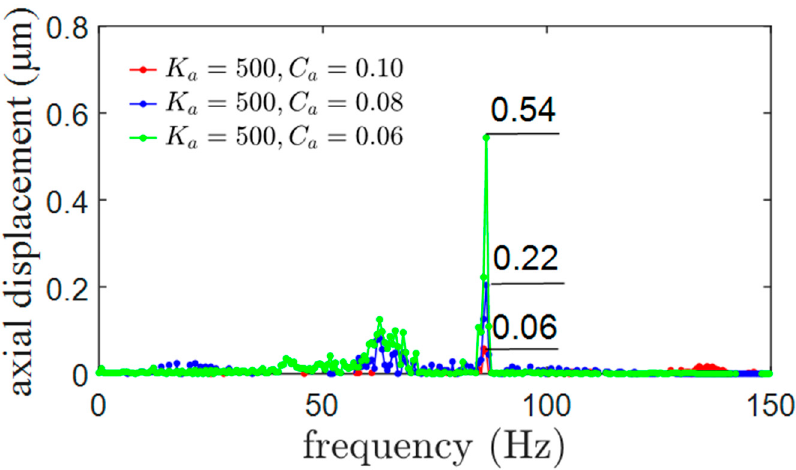
Figure 10. The translational displacements of the 5 ‐ DoF MSMW at different excitation frequencies. Table 2. The sine − swept vibration source.